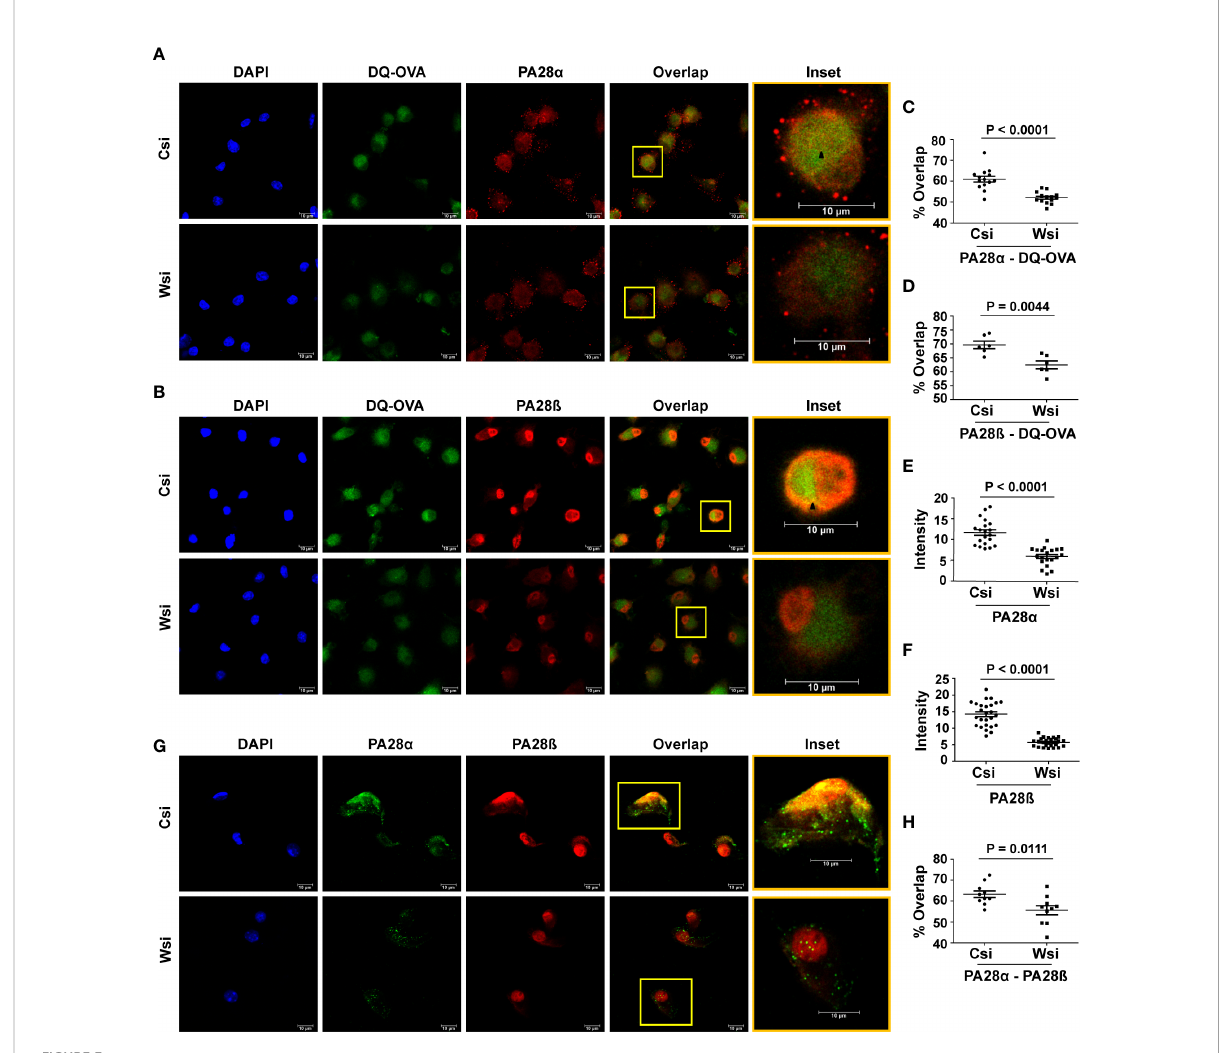
FIGURE 3 Wnt5A mediated DQ-OVA processing is associated with the proteasome regulator PA28 a -PA28 b : Confocal microscopy (A, B) along with Mander ’ s overlap coef fi cient analysis (C, D) n = 2, 6-14 fi elds, each dot representing a fi eld and ImageJ intensity measurement (E, F) n = 3, 7-8 fi elds, each dot representing a cell, demonstrate a signi fi cant decrease in DQ-OVA-PA28 a and DQ-OVA-PA28 b overlap, as well as reduced individual intensities of PA28 a and PA28 b respectively in Wnt5A depleted (Wsi) BMDC as compared to control (Csi). (G , H) : Confocal microscopy of Wsi or Csi BMDC (G) and Mander ’ s overlap coef fi cient analysis (H) (n = 2, 10 fi elds, each dot representing a fi eld) demonstrate reduced PA28 a − PA28 b overlap in Wsi transfected BMDC as compared to control (Csi). Magni fi cation: 63X (2X zoom). The arrow mark (black) shows overlap (yellow spots). The bar represents mean ± SEM (Standard error of the mean) with exact p values depicted in the fi gure. n represents the number of independent experiments. For all calculations, Student ’ s Unpaired t-test was